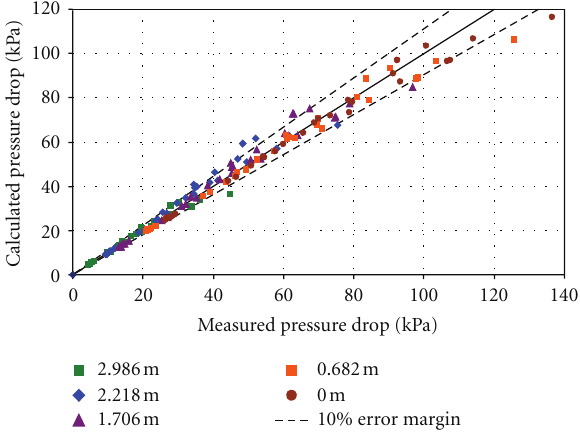
Figure 6: Comparison of predicted and measured two-phase pressure drop in BFBT tests.